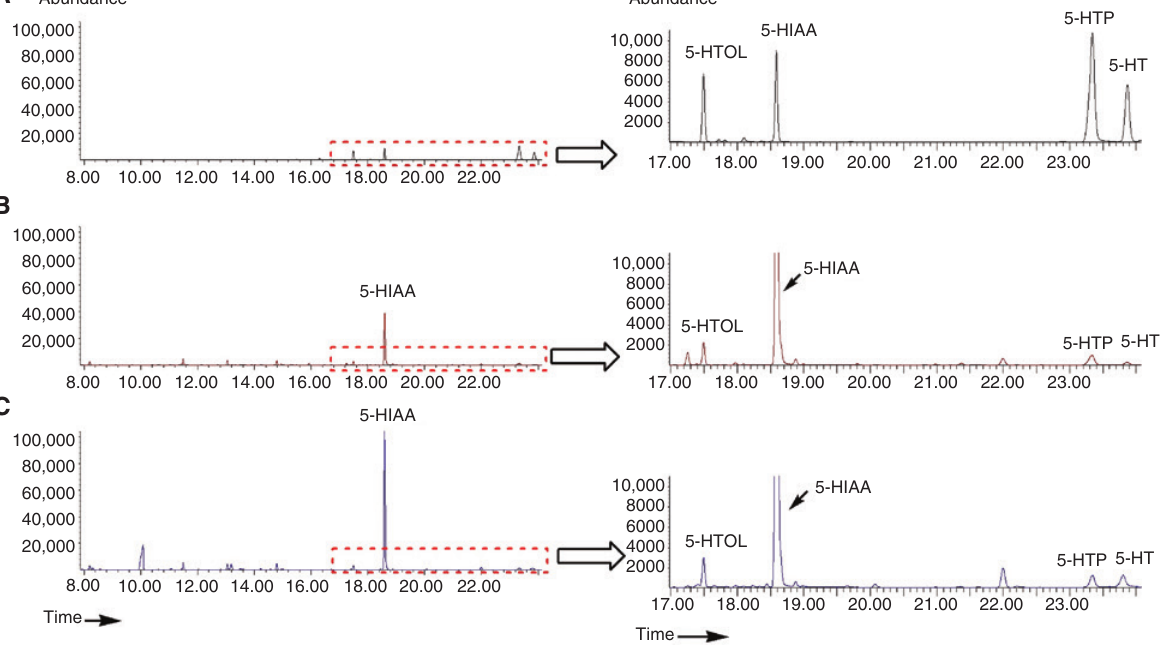
Figure 1: Typical chromatograms of 5-HTOL, 5-HIAA, 5-HTP and 5-HT analysis by the GC-MS method. (A) Aqueous standard of 10 μ g/L 5-HTOL, 10 μ g/L 5-HIAA, 40 μ g/L 5-HTP and 40 μ g/L 5-HT, respectively, (B) an extract CSF from ALL, (C) an extract CSF from